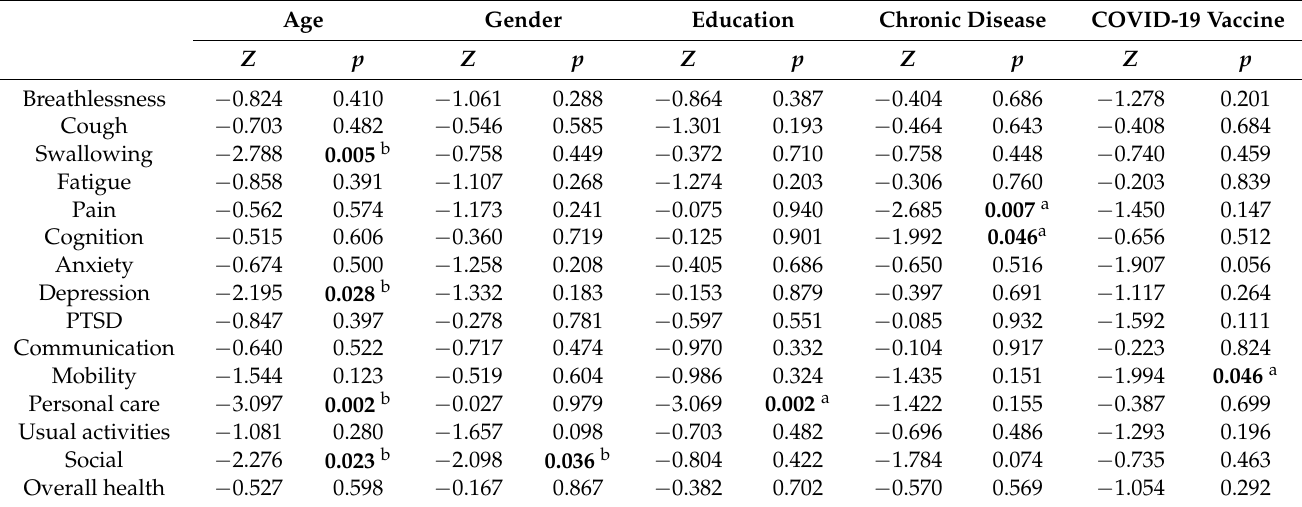
Table 3. Subgroup analysis for changed scores of symptoms, functional difficulties, and overall health measured using